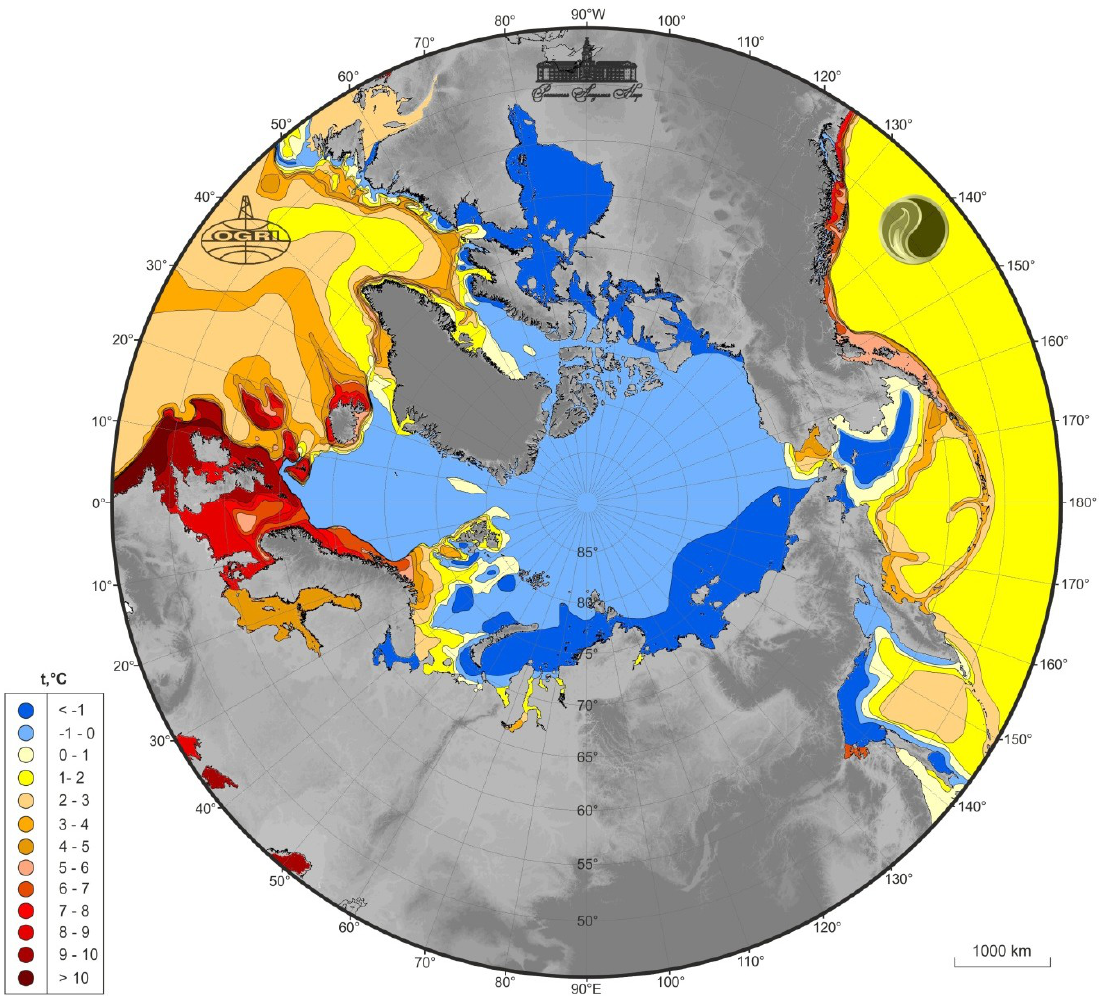
Figure 6. Cartographic scheme of near-bottom water temperatures distribution in the Northern Hemisphere (above the 45° latitude), obtained as a result of analysis of data, demonstrated in Figure 5.